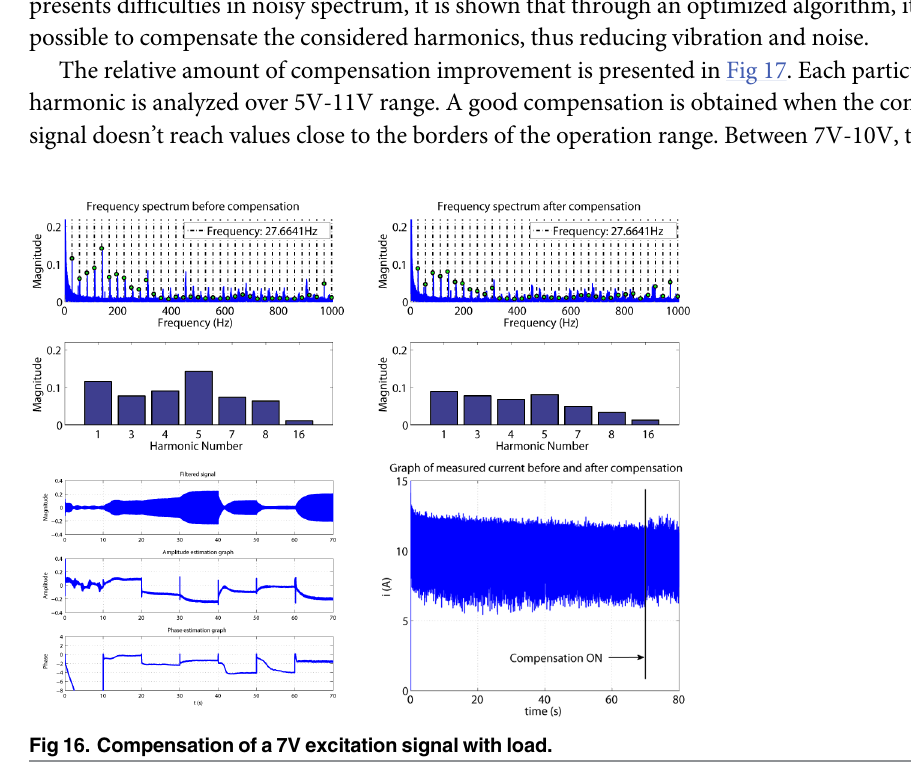
Fig 16. Compensation of a 7V excitation signal with